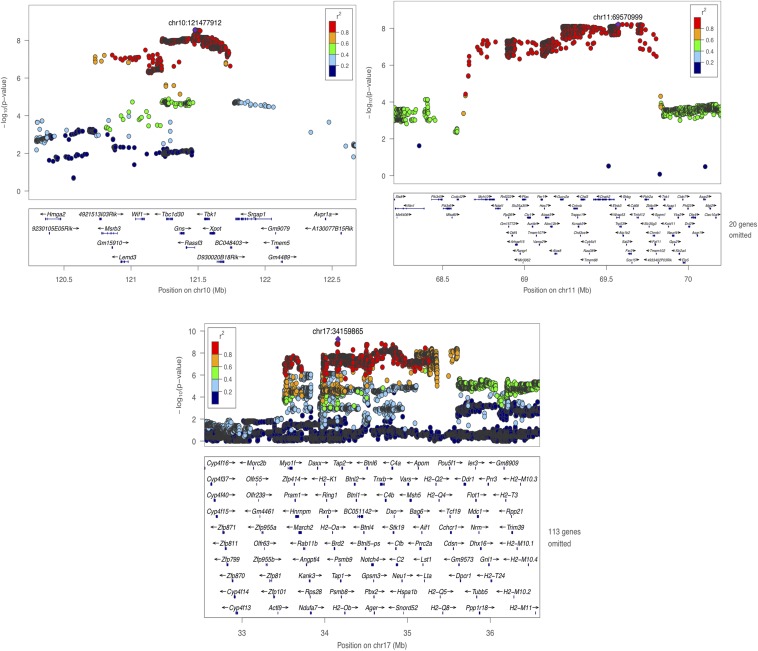
Genome-wide significant loci for micronucleus formation on chromosomes 10, 11 and 17. The −log10 P-values of imputed SNPs associated with micronucleus levels are shown on the left Y axis. The horizontal axis gives chromosome and position in megabases (Mb). Genes within the regions are shown in the bottom panels (for clarity, as indicated on the figure, some gene names have been omitted). Linkage disequilibrium of each SNP with top SNP, shown in large purple diamond, is indicated by its color. The plots were drawn using LocusZoom (Pruim et al. 2010).